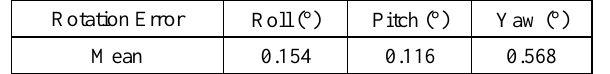
Table 1 . Rotation errors analysis